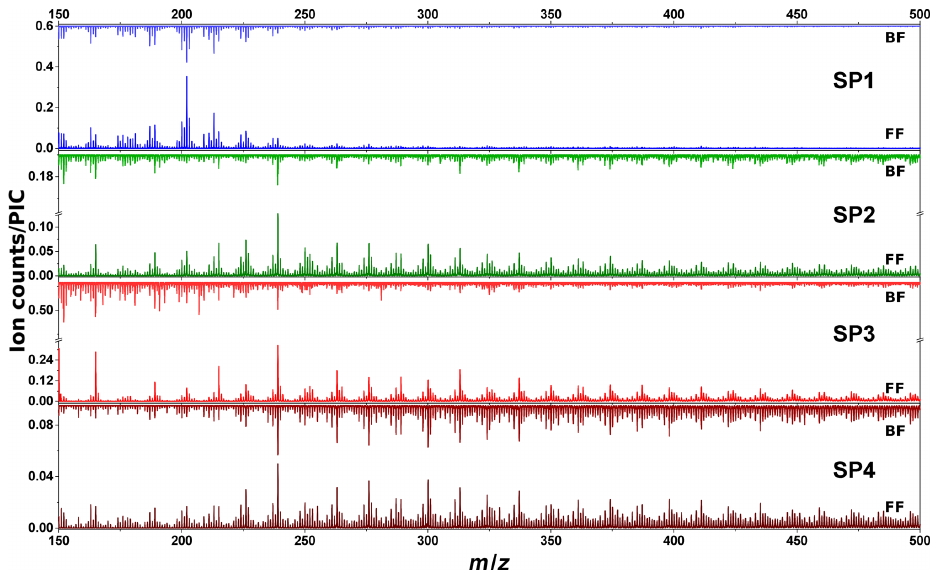
Figure 6. ToF-SIMS mass spectra of samples SP1, SP2, SP3, and SP4 obtained in positive polarity for front filters (lower spectra) and back filters (upper spectra). For visualization purposes, we focus on the m/z 150–500 range. Note that for SP2 and SP3 samples front and back filters have different scales.